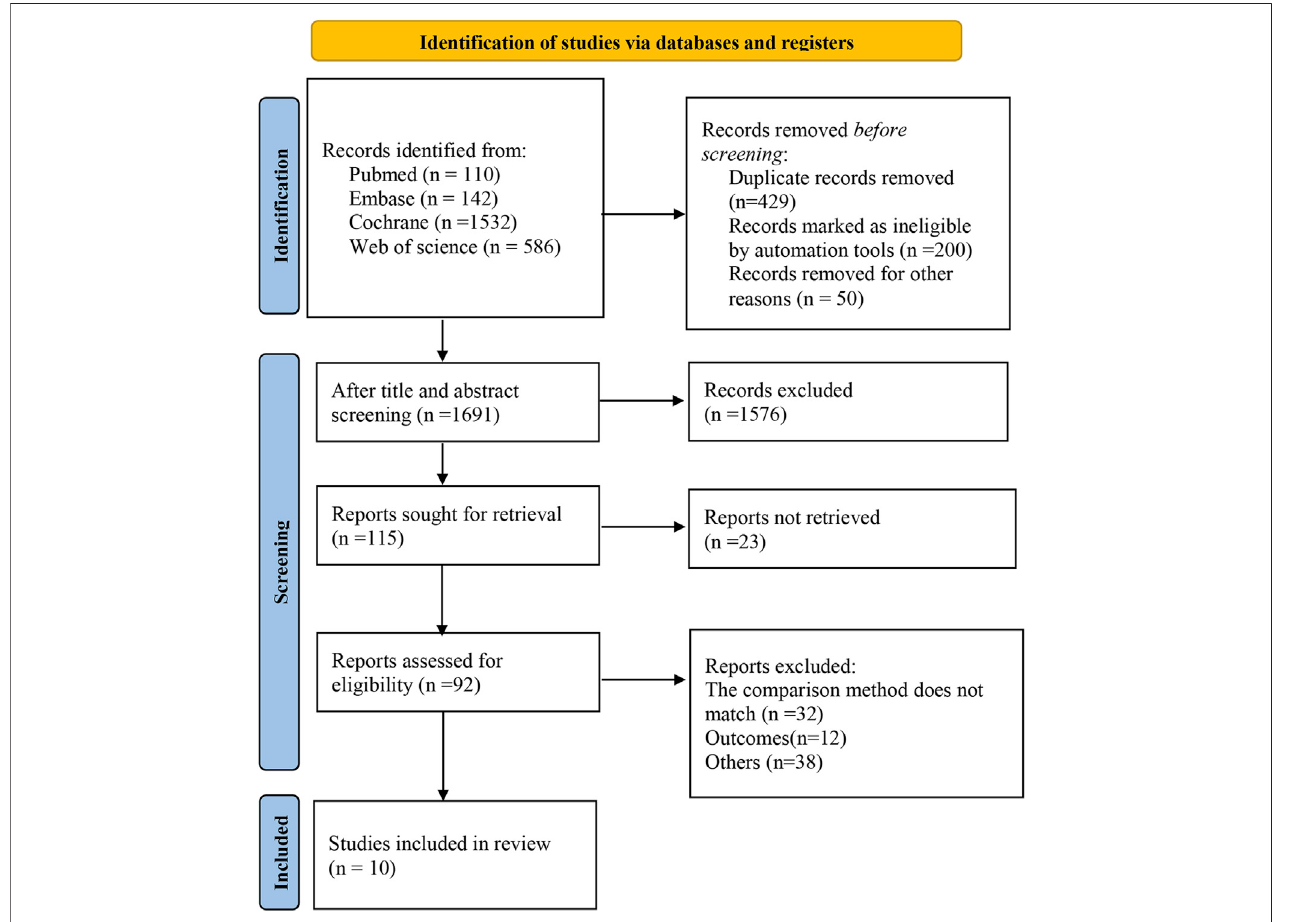
FIGURE 1 | Literature screening process and